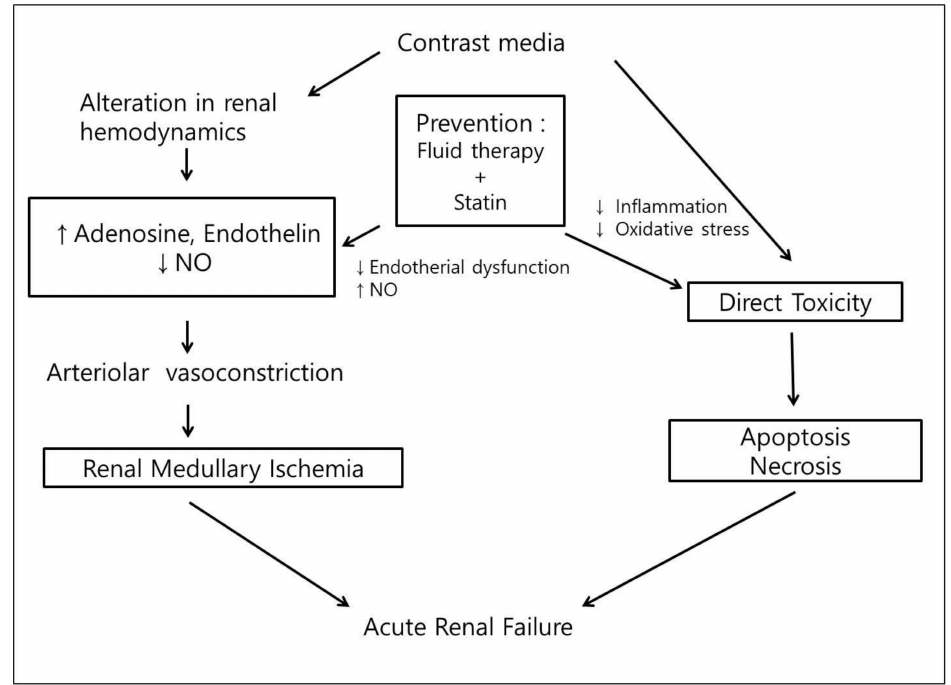
Figure 3. Potential mechanisms of beneficial e ff ects of statins on the CIN. NO: nitric